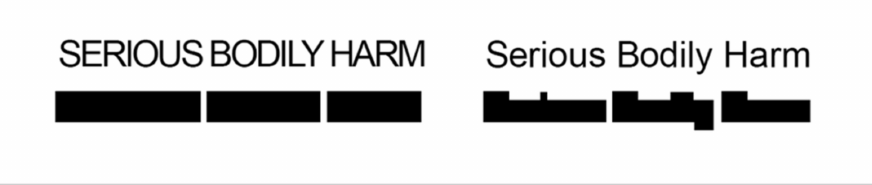
Figure 7. Typeface. Uppercase text forms visually uniform blocks that do not lend themselves to rapid discrimination. Words rendered in lowercase form distinctive shapes and patterns that are more quickly understood by the